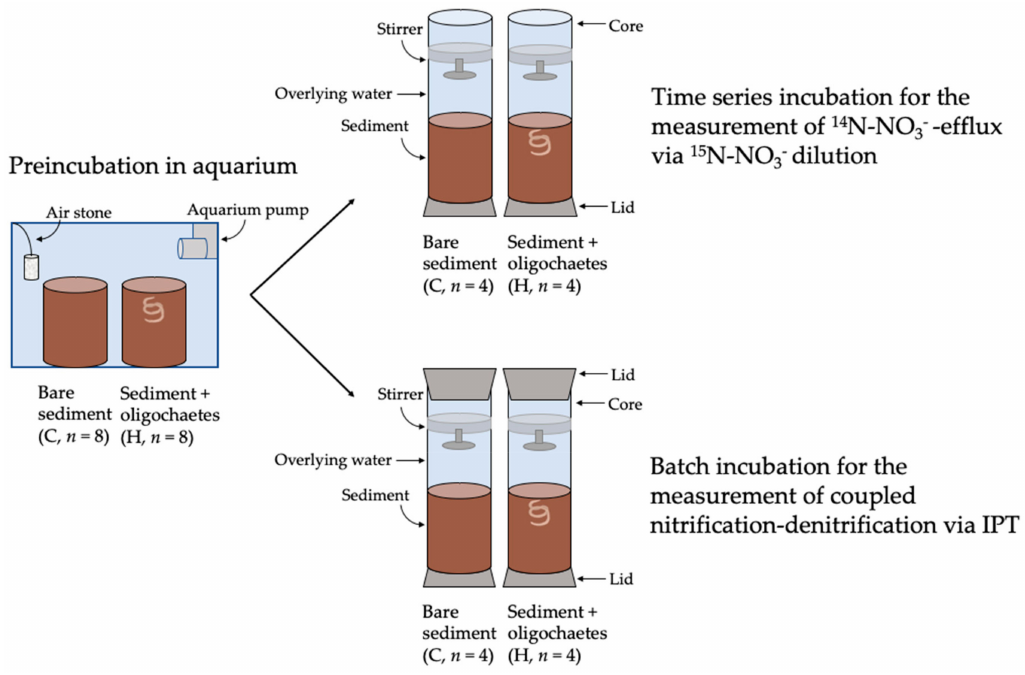
Figure 1. A scheme of the experimental design that consisted of two treatments: bare sediment (C, n = 8) and sediment with oligochaetes (H, n = 8). After one week of preincubation in the aquarium, microcosms were separated into two groups in order to measure 14 N-NO 3 − -e ffl ux (Section 2.7.2) and coupled nitrification-denitrification (Section